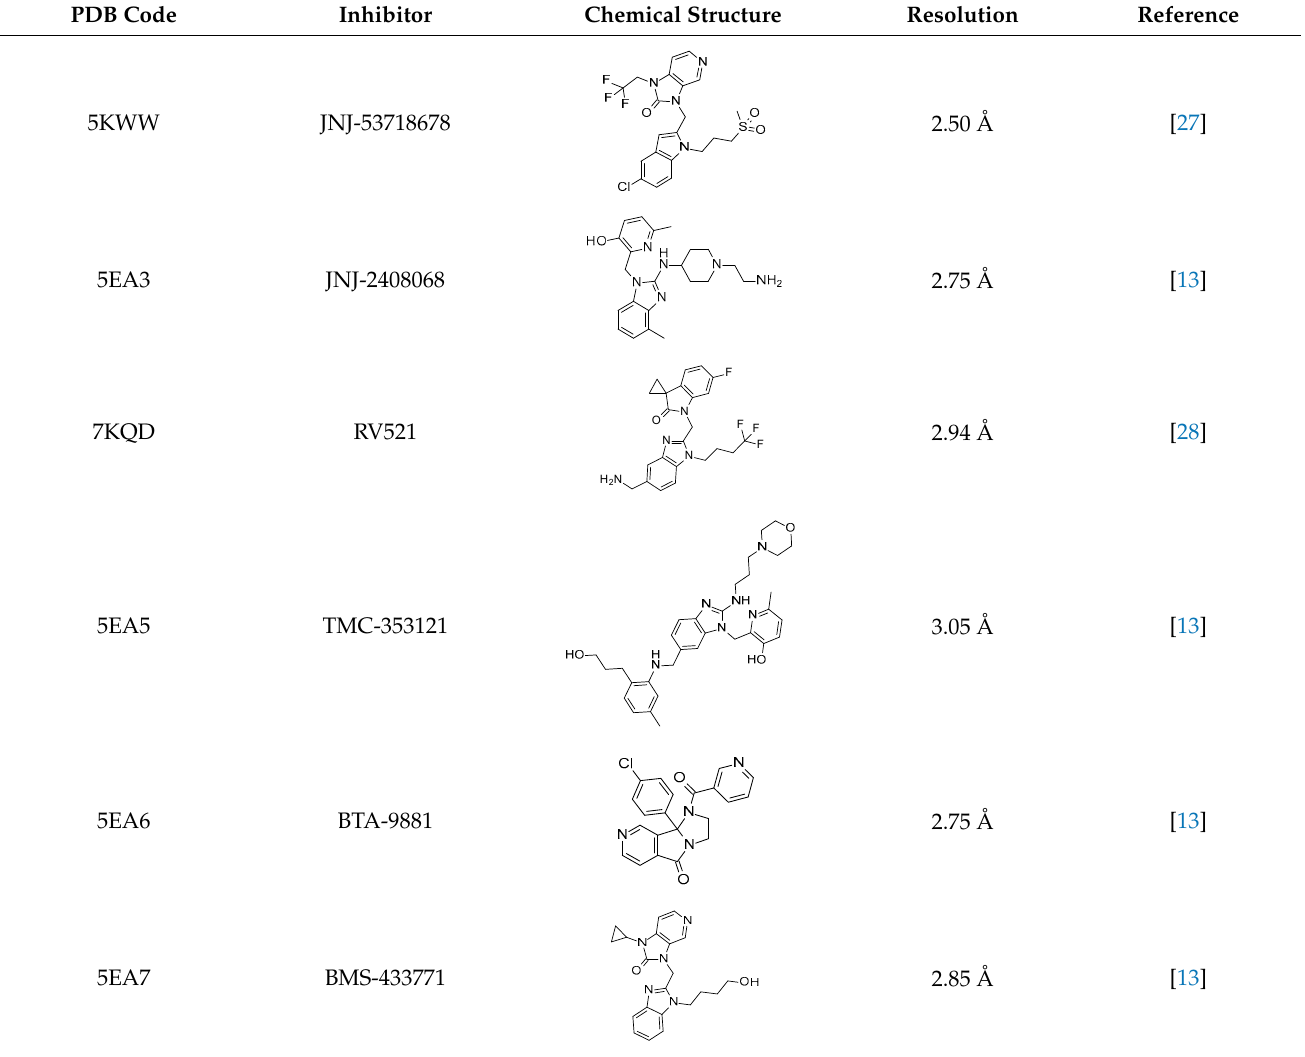
Table 1. Scheme of the selected X-ray data of the RSV F protein in presence of different inhibitors, as collected from the protein data bank. The PDB codes related to non-benzimidazole-containing co-crystallized inhibitors are shown in italic.